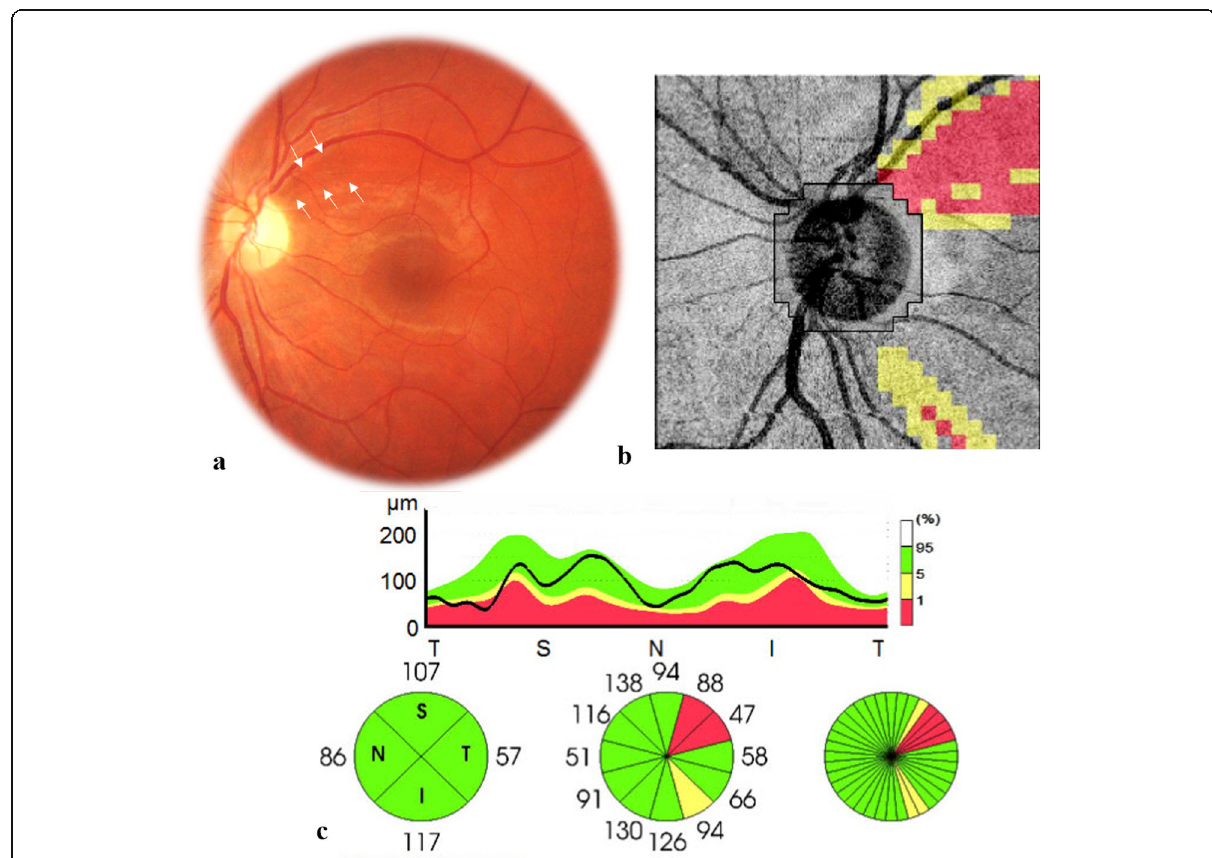
Table 1 Succession of clinical events in the reported case